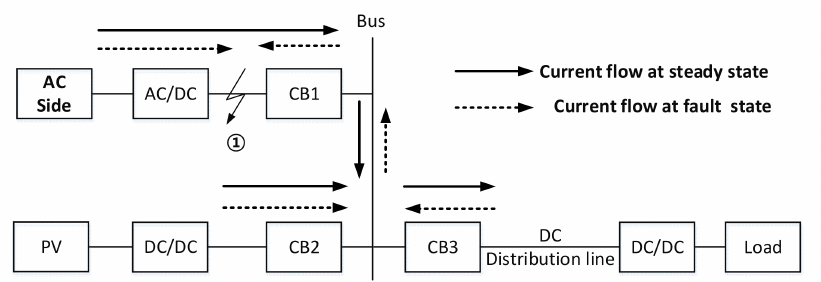
Figure 2. Comparison of the current flow in the steady state and in a fault in section 1 (cid:13) .